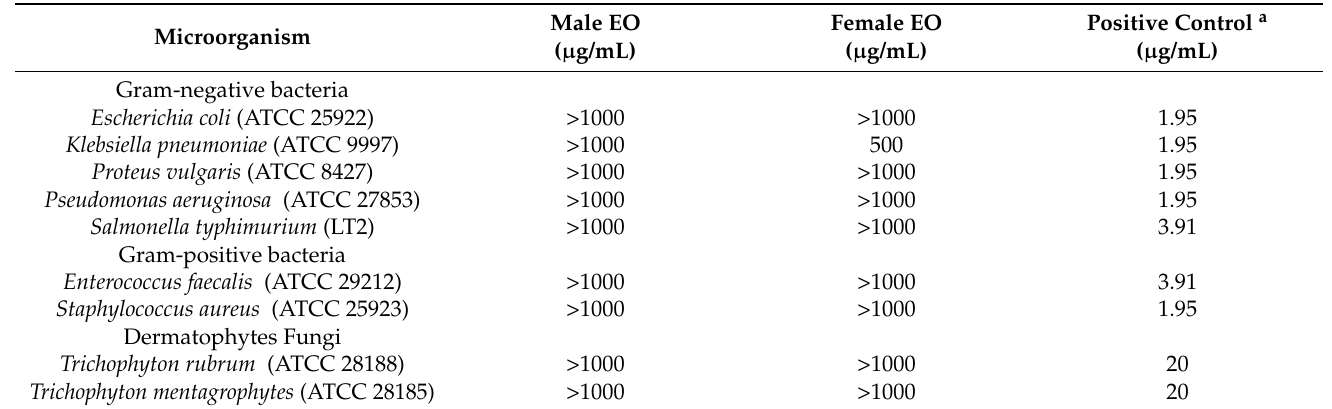
Table 4. Antimicrobial activity of essential oil from Hedyosmum racemosum .